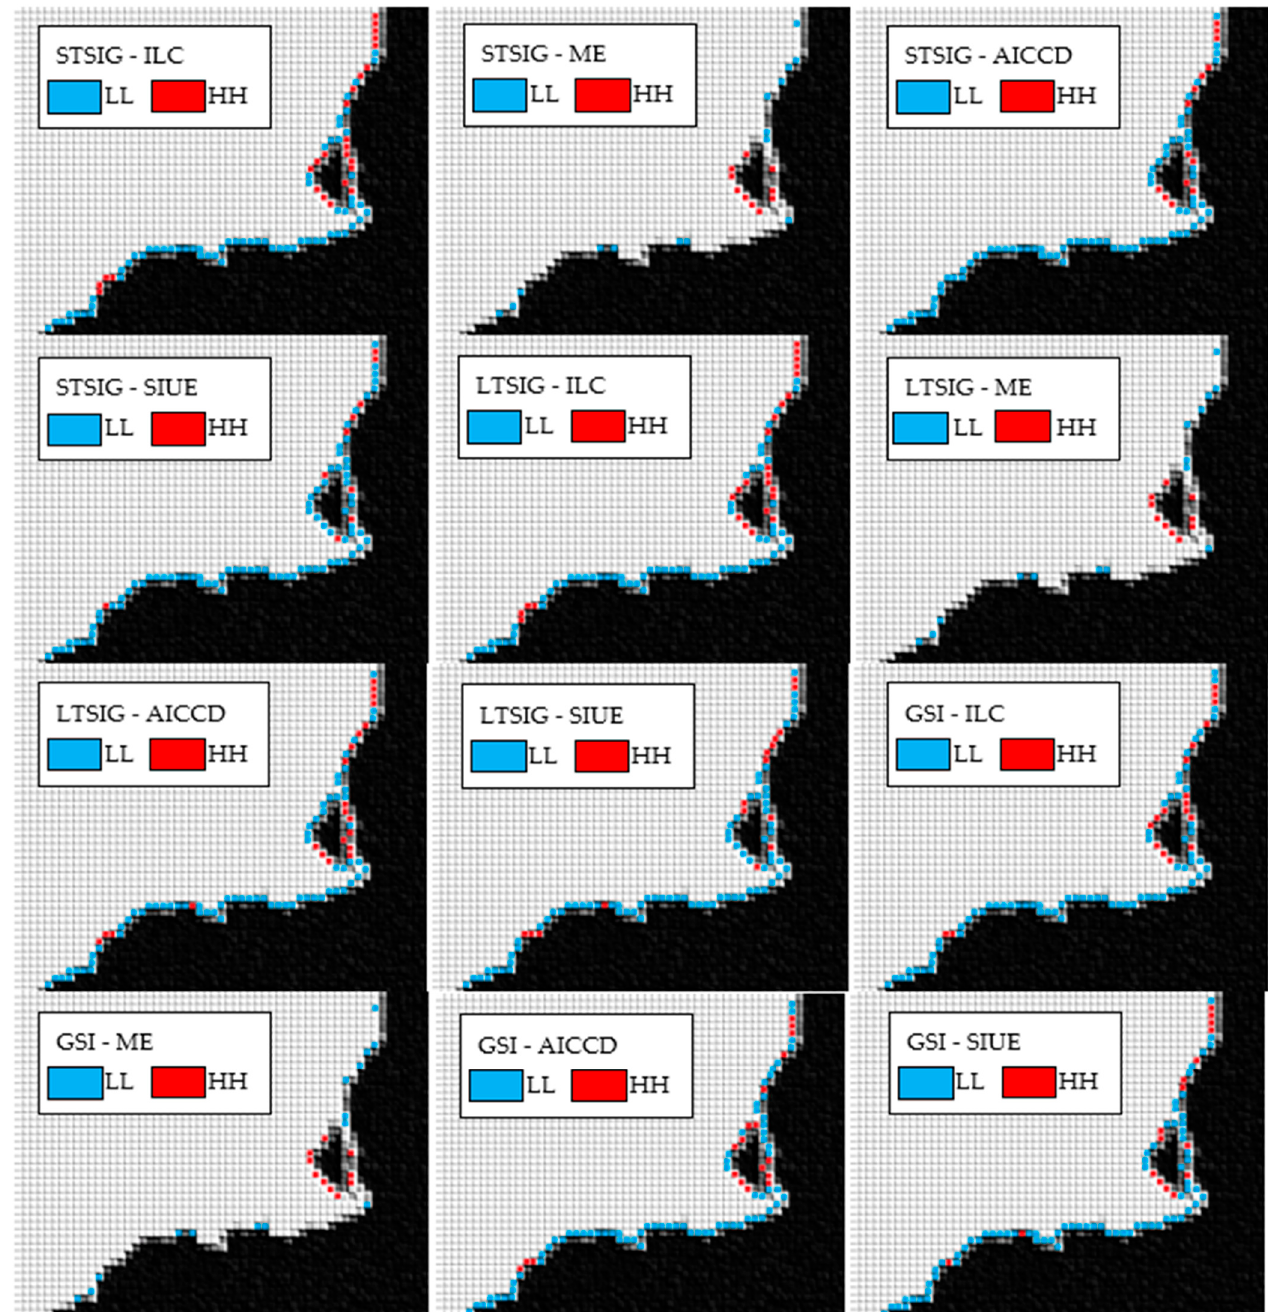
Figure 6. Hot- and cold-spot LISA analysis for spatial statistical correlation between port areas configuration and coastal impacts indicators.